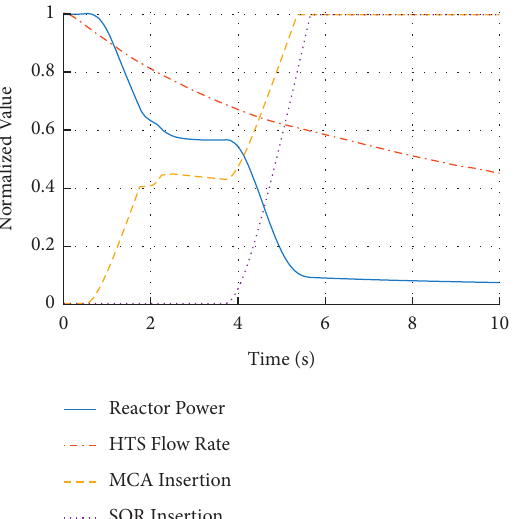
Figure 30: Normalized power, heat transport system flow rate, and rod insertion for loss of flow event. Rod insertion is given for the mechanical control absorbers (MCAs) and shutoff rods (SORs).